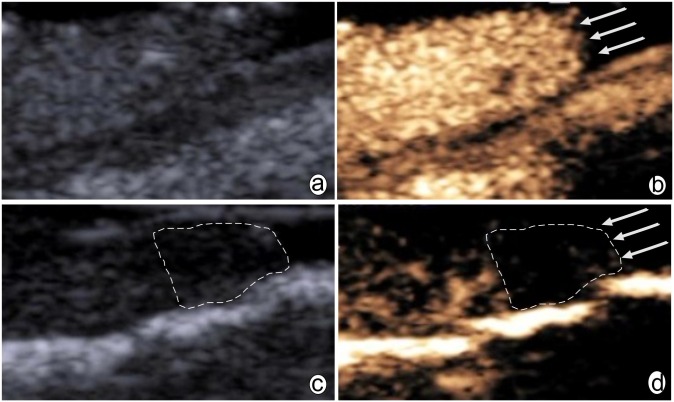
CEUS images after insonation.
a, b, Uniform perfusion of contrast agent in the MB group; c, d, A representative CEUS image showed a perfusion defect (arrow indicates the trauma, breakage the wound, and dotted line shows the range of defects. The area beyond the dotted line also showed an irregular defect) in MEUS group.